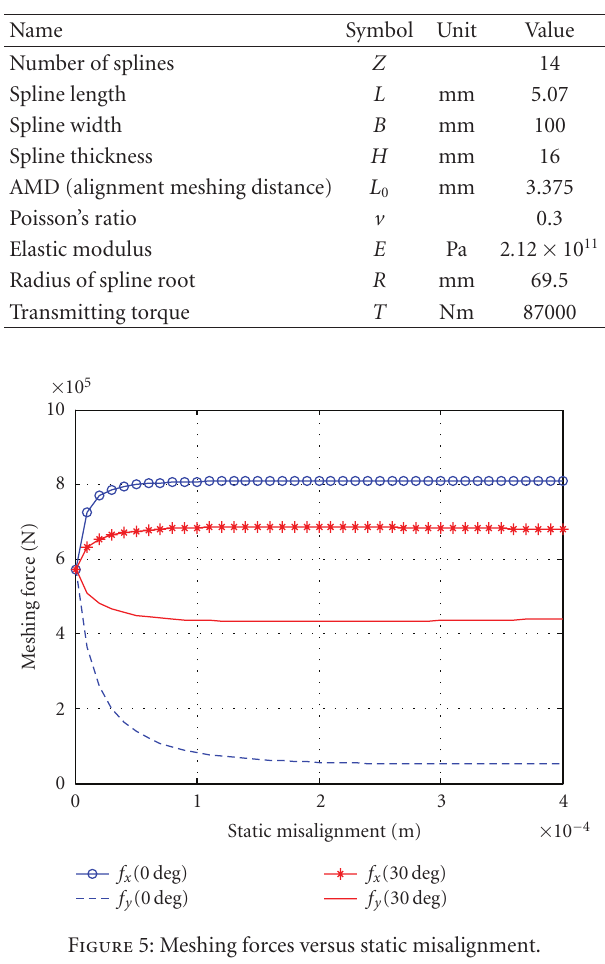
Table 1: Structure parameters of spline coupling.